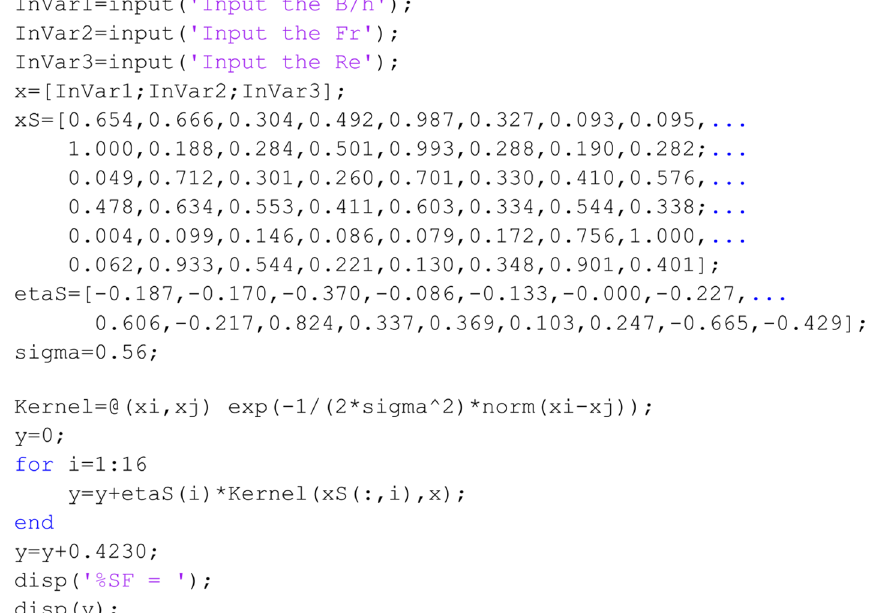
Fig. 3 Output of the more appropriate SVR model